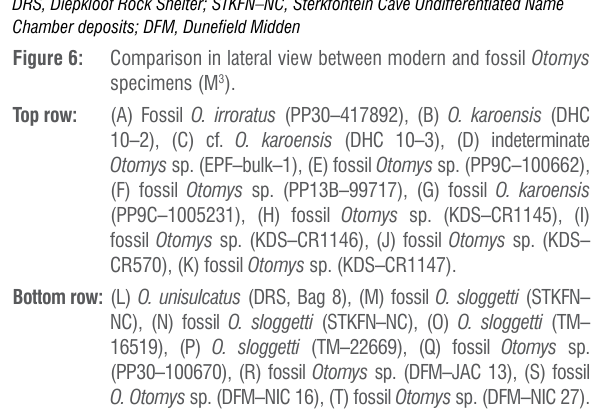
Figure 6: Comparison in lateral view between modern and fossil Otomys specimens (M 3 ).